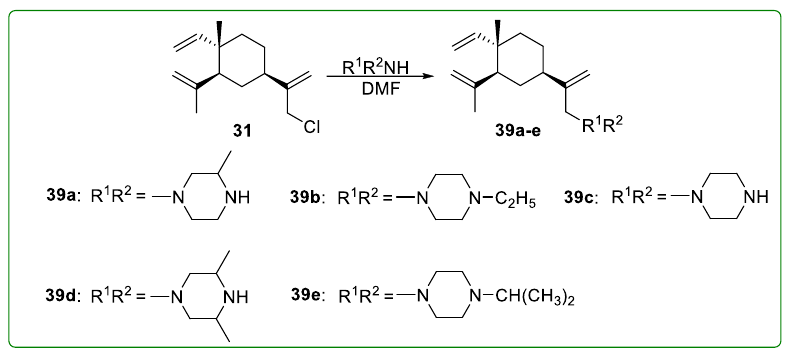
Figure 10. Chemical structures of β -elemene aminated derivatives 39a – e .